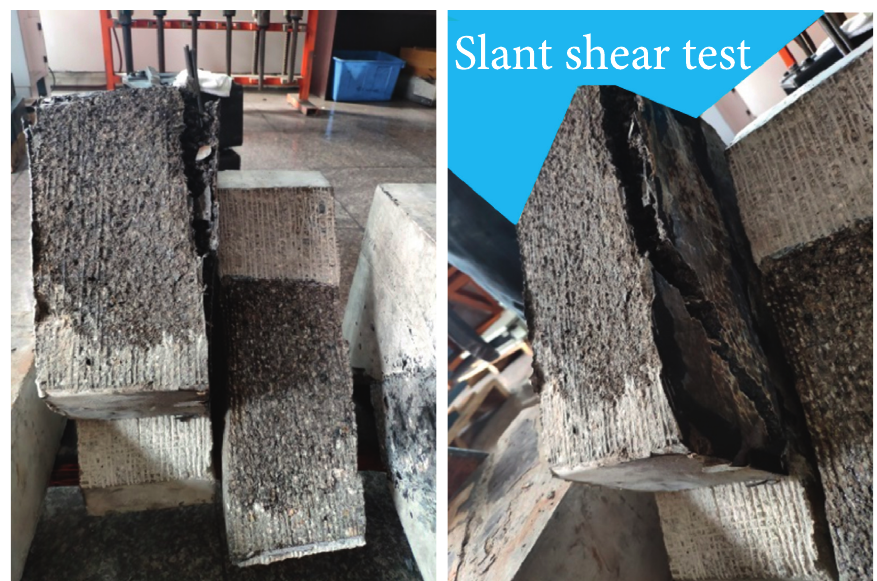
Figure 10: The failure mode of slant shear test specimen 2.